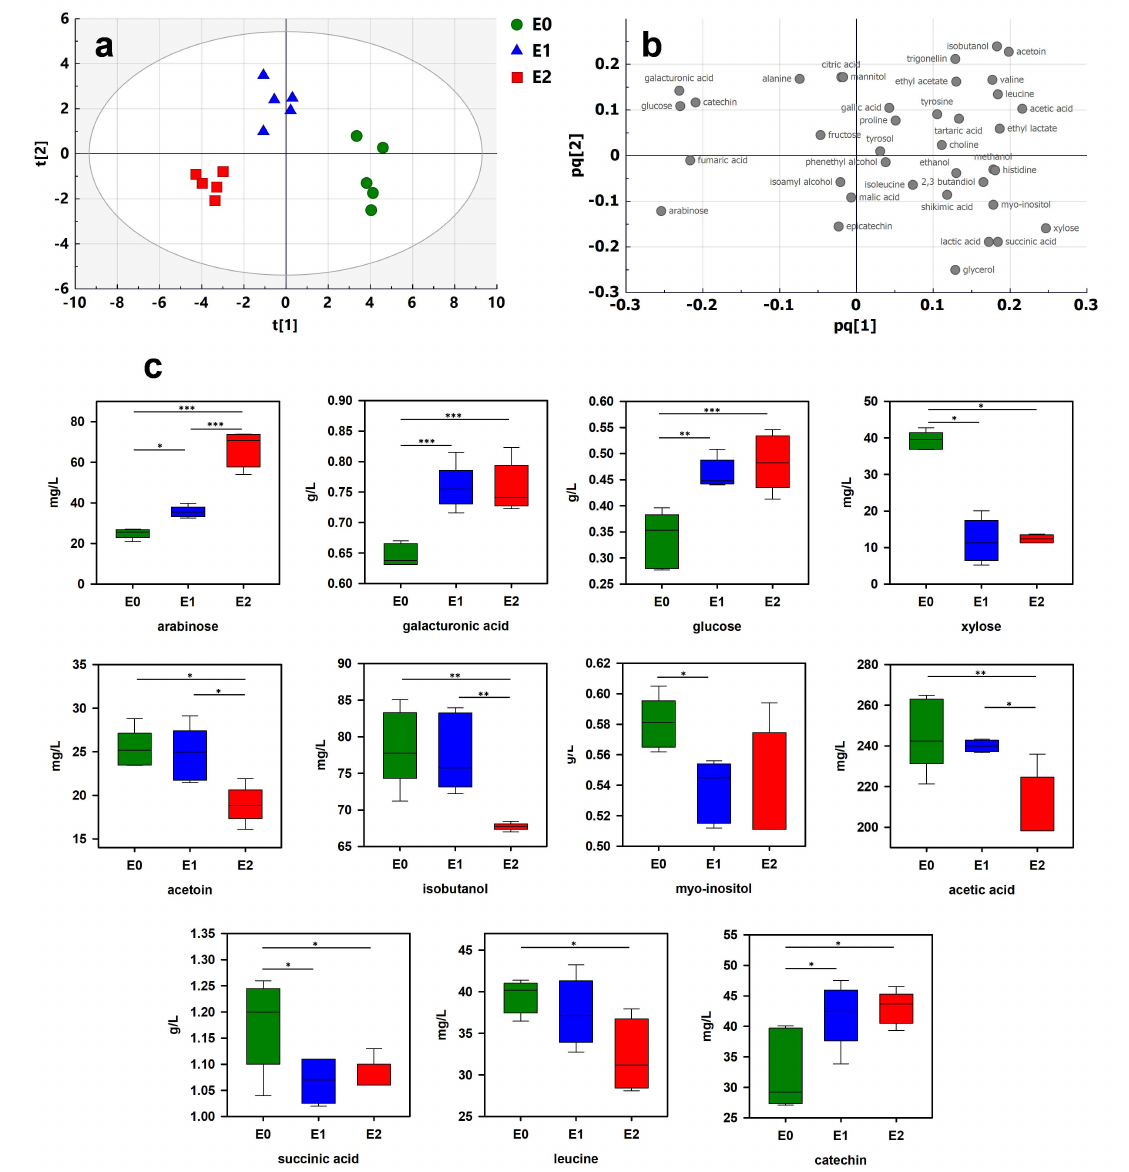
Figure 3. Multivariate analysis of 1 H-NMR spectra of wine samples treated by different enzymes (E0: untreated; E1: enzyme 1; E2: enzyme 2): ( a ) OPLS-DA score plot; ( b ) loading plot; ( c ) boxplots of 11 most discriminant wine constituents (t[1] and t[2]: first and second predictive components; pq[1] and pq[2]: first and second predictive component loadings). The significance in the difference was calculated by ANOVA followed by Tukey’s multiple comparison test (indicated as * p < 0.05, ** p < 0.01, *** p <